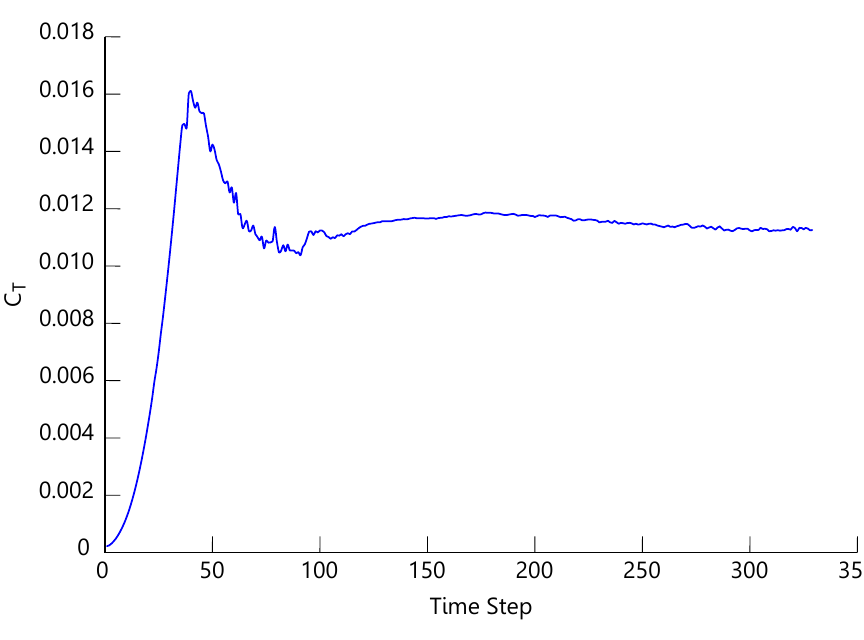
Figure 8. Thrust coefficient